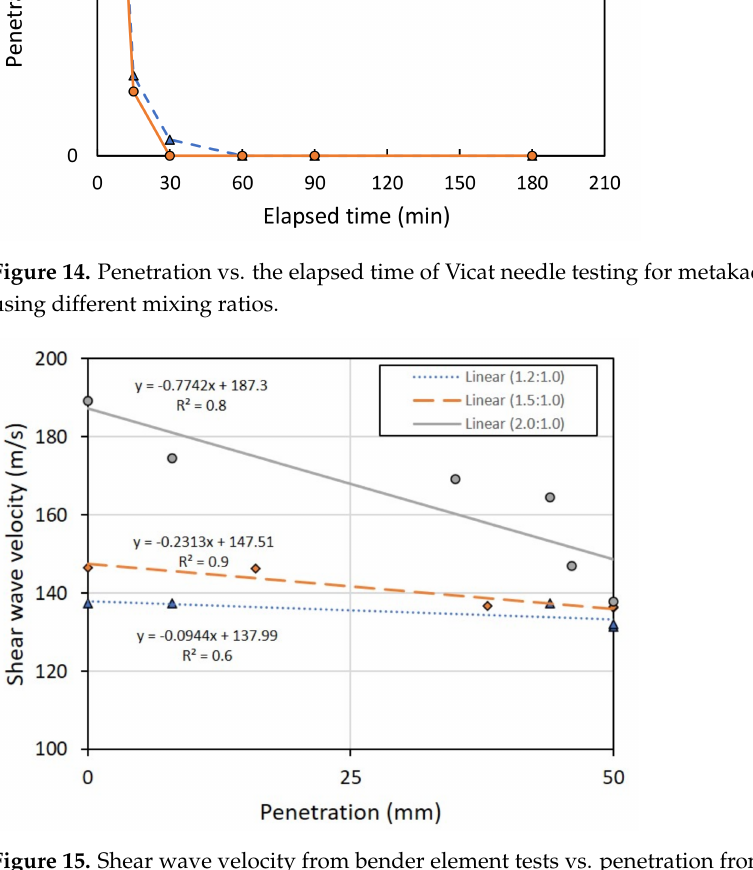
Figure 15. Shear wave velocity from bender element tests vs. penetration from Vicat